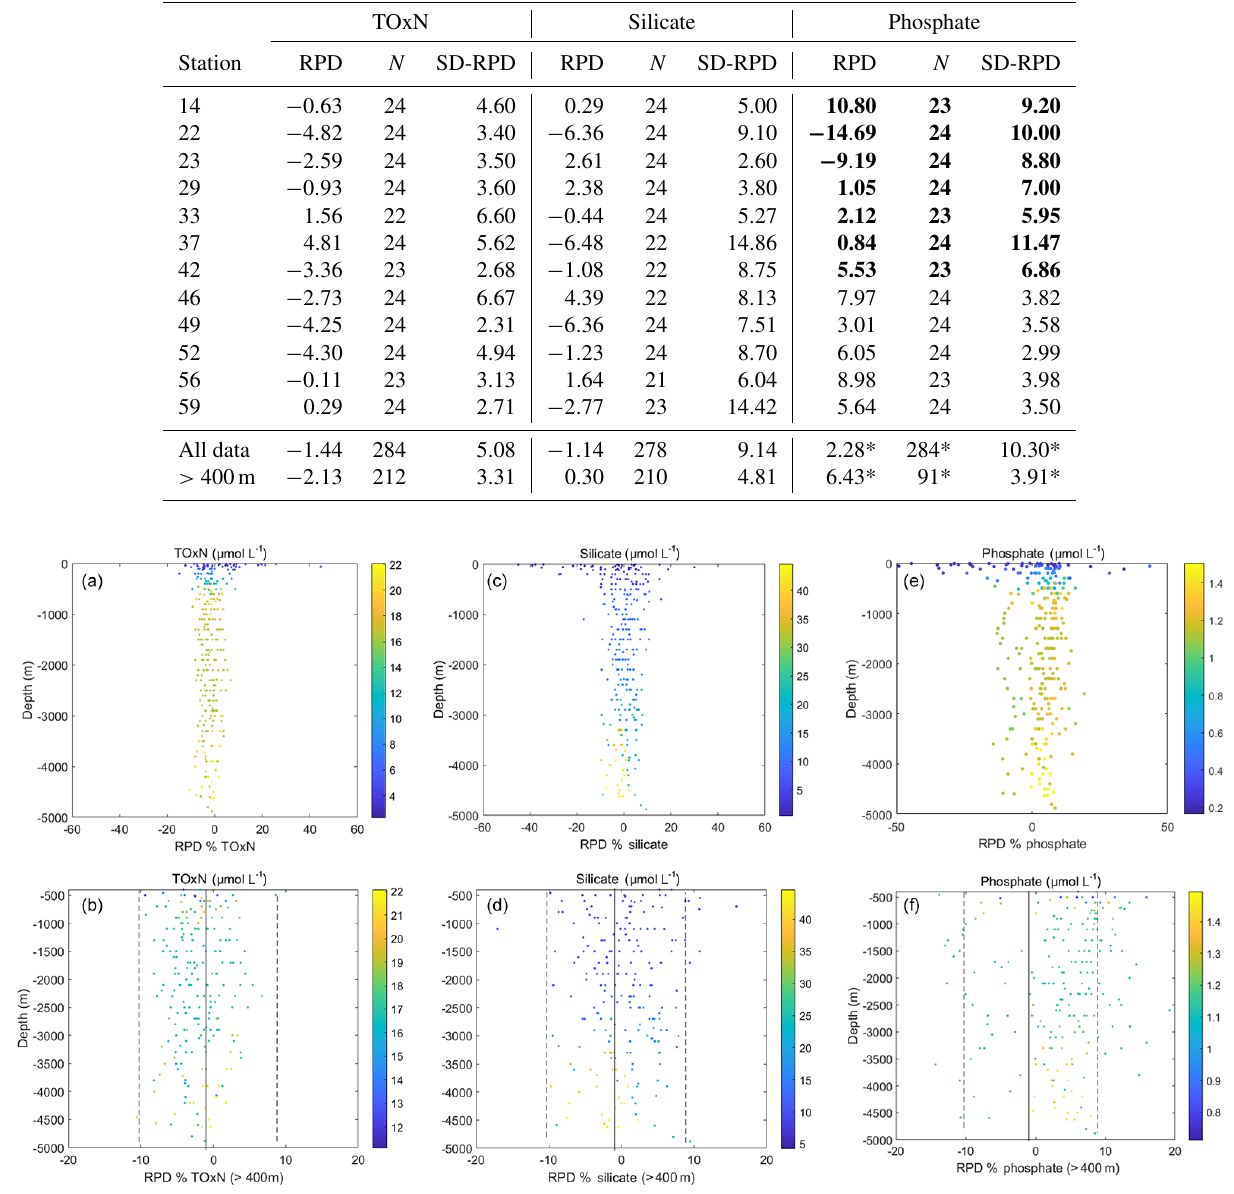
Figure 3. Relative percentage difference (RPD MI − DAL ) calculated as (MI conc − Dal conc) / average conc × 100% for each nutrient for the whole water column and for depths > 400m. The colour bar for each plot is the average concentration (µmolL − 1 ) of each nutrient (i.e. the average concentration from both systems) at that depth. Note the use of different y -axis scales for the different subsets.